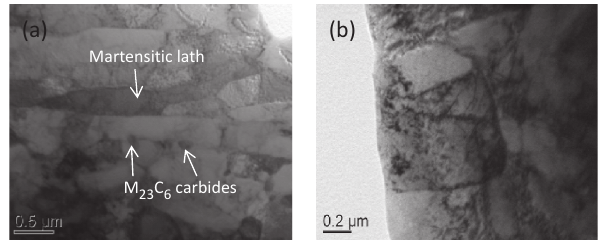
Figure 1: TEM micrographs of the initial state of P92 steel: (a) the pronounced tempered martensitic matrix and (b) high density of